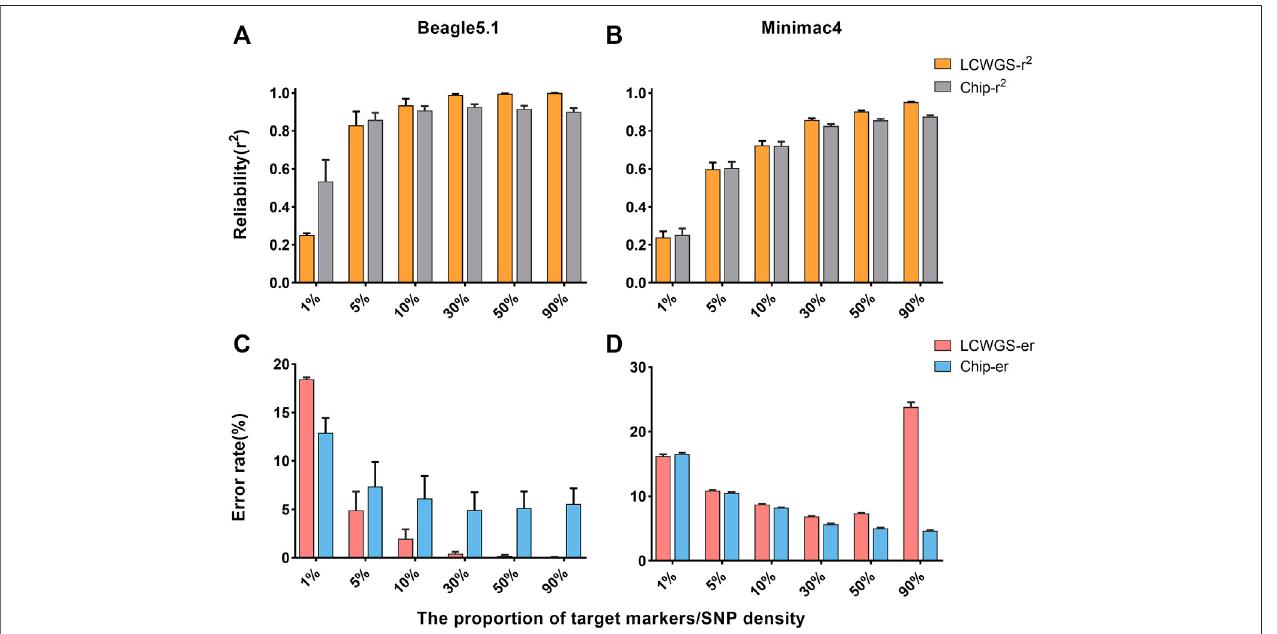
FIGURE 4 | Comparison of imputation accuracy using two types of data. (A) Comparison of reliability in Beagle5.1. (B) Comparison of reliability in Minimac4. (C) ComparisonoftheerrorrateinBeagle5.1. (D) Comparison oftheerrorrateinMinimac4.LCWGS-r 2 ,imputationreliabilityuseLCWGsequencedata;Chip-r 2 ,imputation reliability use chip data; LCWGS-er, imputation error rate use LCWG sequence data; Chip-er, imputation error rate use chip